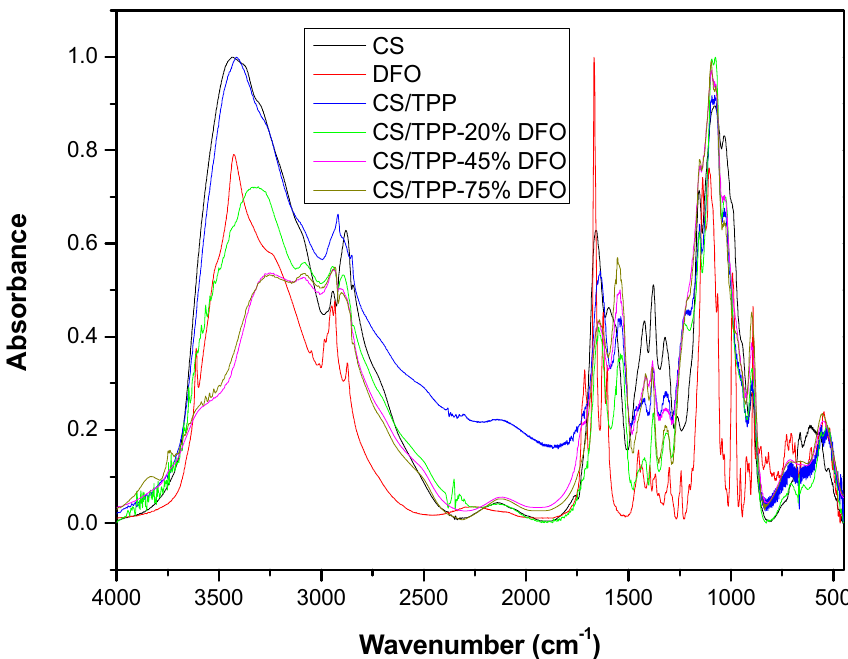
Figure 4. FTIR spectra of CS, DFO, CS / TPP and their nanoparticles containing di ff erent amounts of DFO.